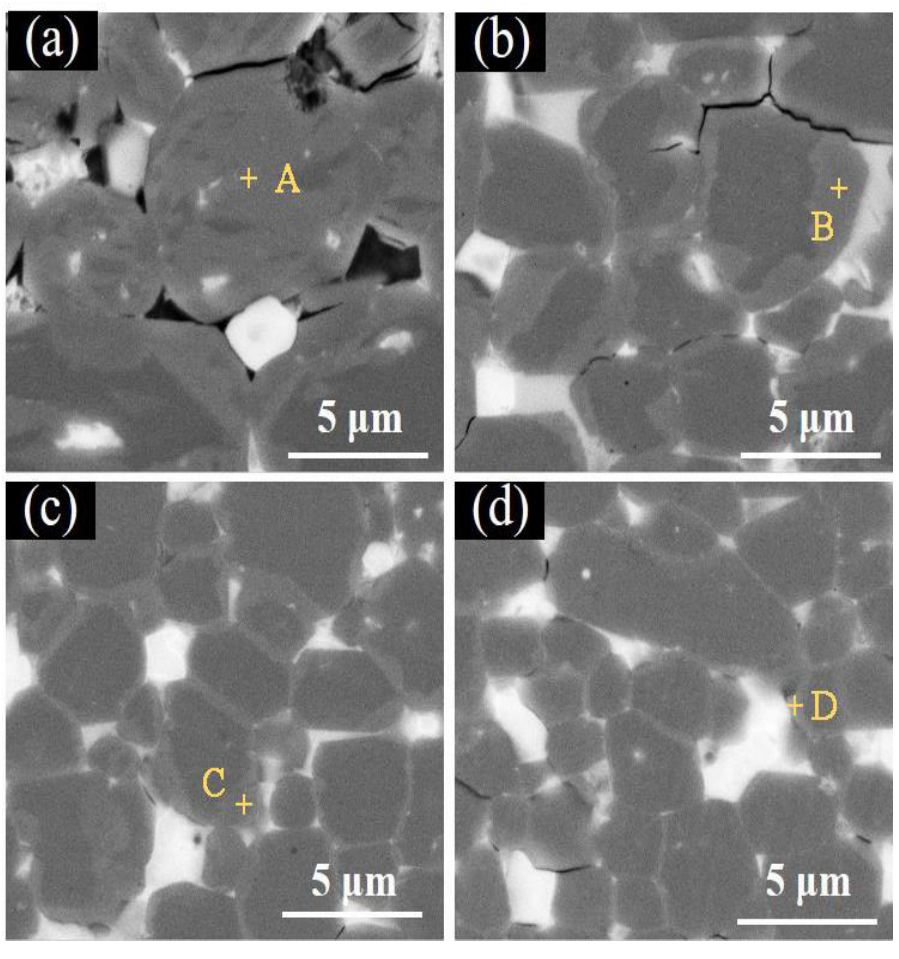
Figure 5. The BSE-SEM images at 15 µ m from the surface of ( a ) G4.9D, ( b ) G4.2D, ( c ) G3.2D, and ( d ) G3.0D diffused magnets. Table 2. The elemental contents (wt.%) of the selected position in Figure 5 using EDS analysis.